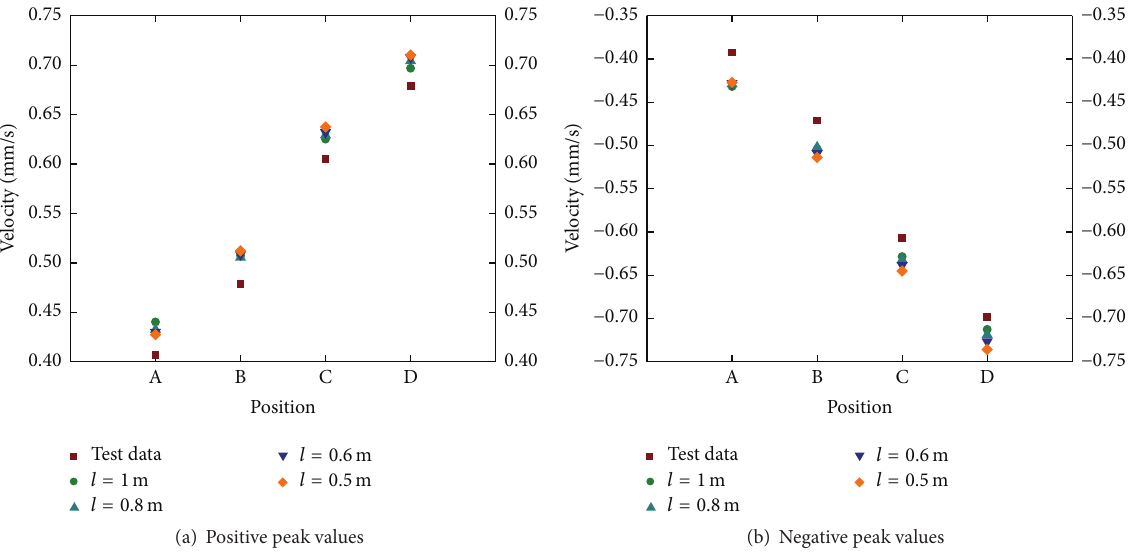
Figure 4: Vibration velocities under different element